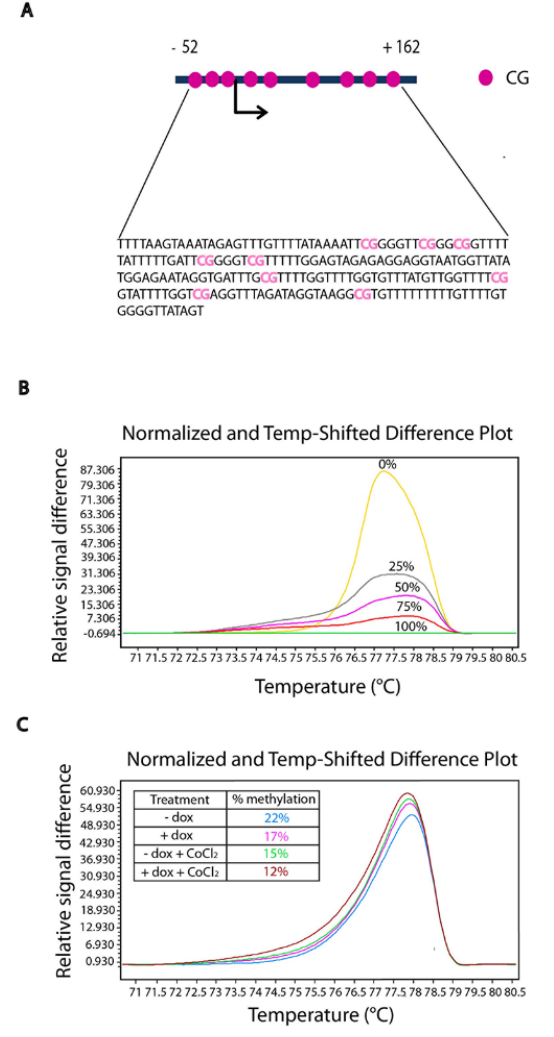
Figure 7. High-resolution melting (HRM) analysis of TFF1 promoter methylation. Difference plots of the TFF1 promoter DNA methylation pattern in AGS-AC1 cells after 72 h of induction with doxycycline (1 μg/mL) and/or with CoCl 2 200 μM. ( A ) TFF1 promoter region analyzed containing 9 CpG; ( B ) Normalized difference plot of control DNA samples with known percentage of methylation; ( C ) Normalized difference plot of AGS-AC1 DNA samples after treatments.